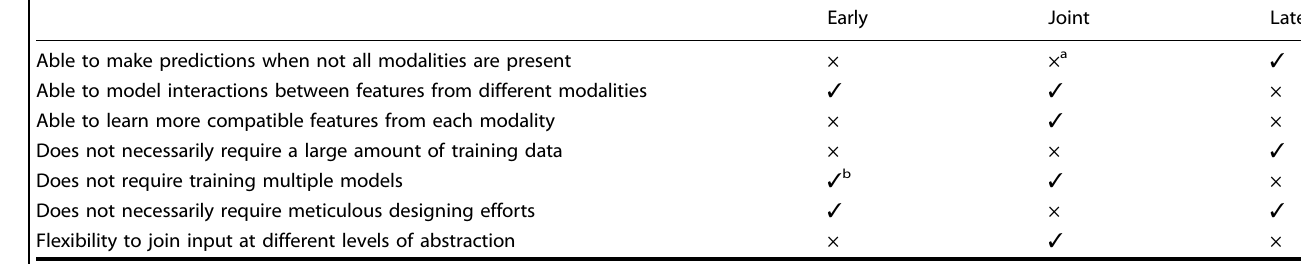
Table 2. Properties and bene fi ts of different fusion strategies.